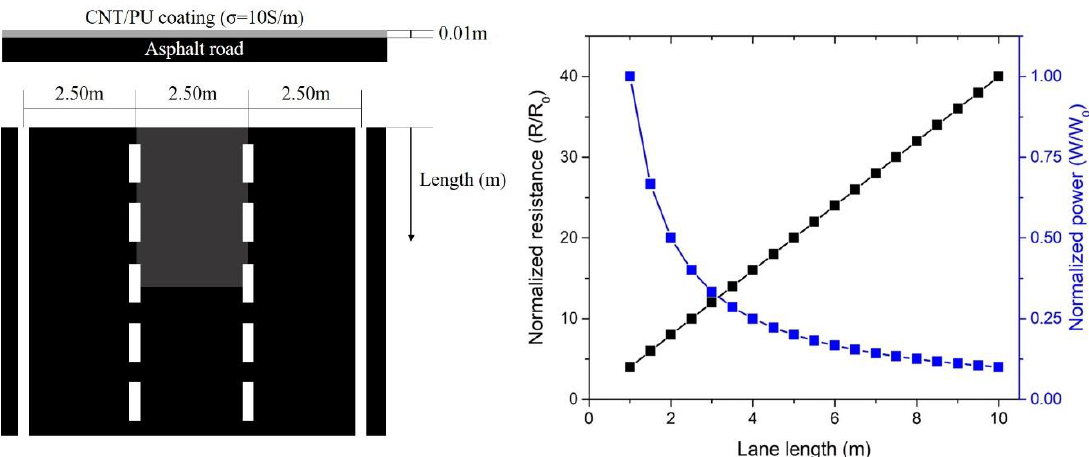
Figure 8. Schematic illustration of CNT/PU coating on the asphalt roads (left) and Estimated normalized resistance and power of the CNT/PU coating on asphalt road (right).